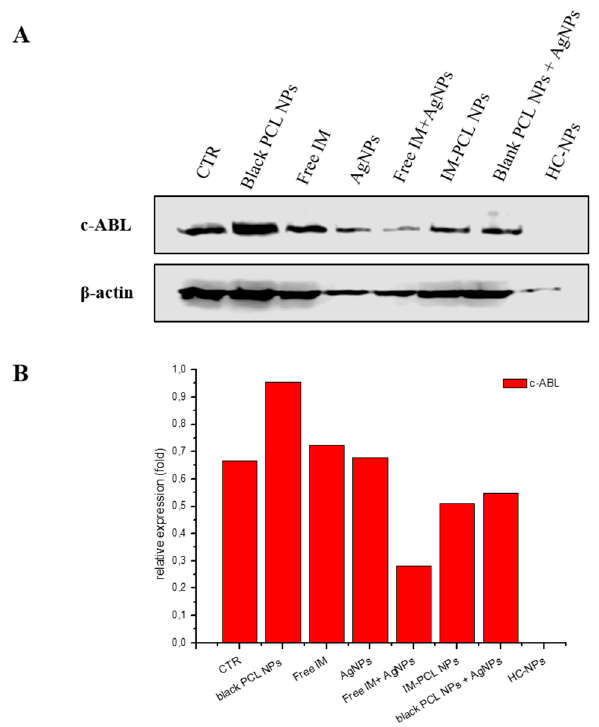
Figure 6. Inhibition of the oncoprotein BCR-ABL with western blotting after 7 days of treatment with different formulations ( A ) and densitometry analysis ( B ) of c-ABL levels normalized to the β -actin used as control. Representative measurements of three independent experiments have been reported.